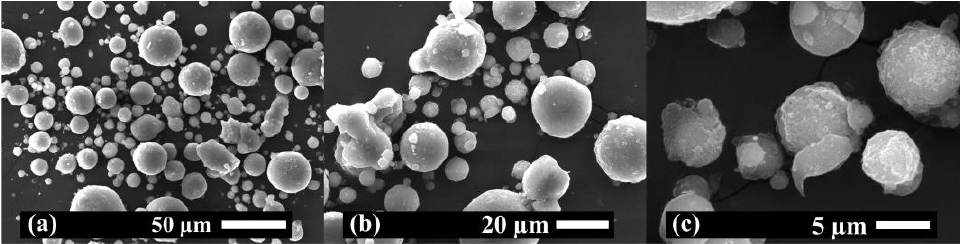
Figure 1. SEM images of Mg microparticles at ( a ) × 500, ( b ) × 1000 and ( c ) × 4000 magnifications.